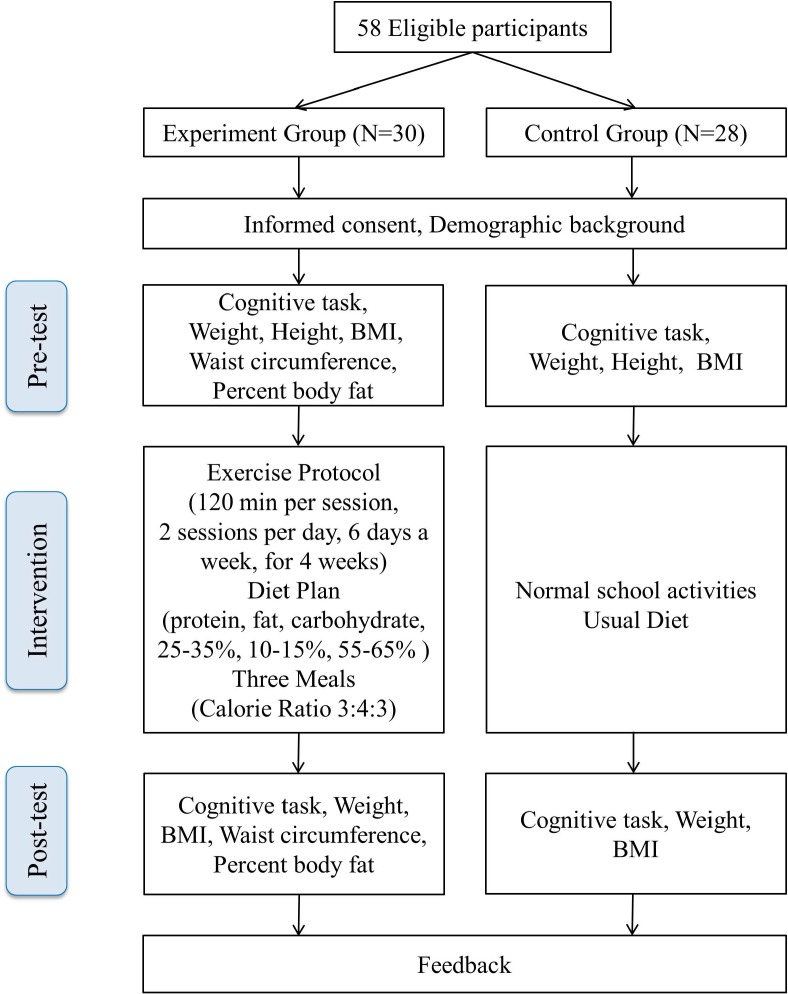
Flow chart of the experimental procedure.